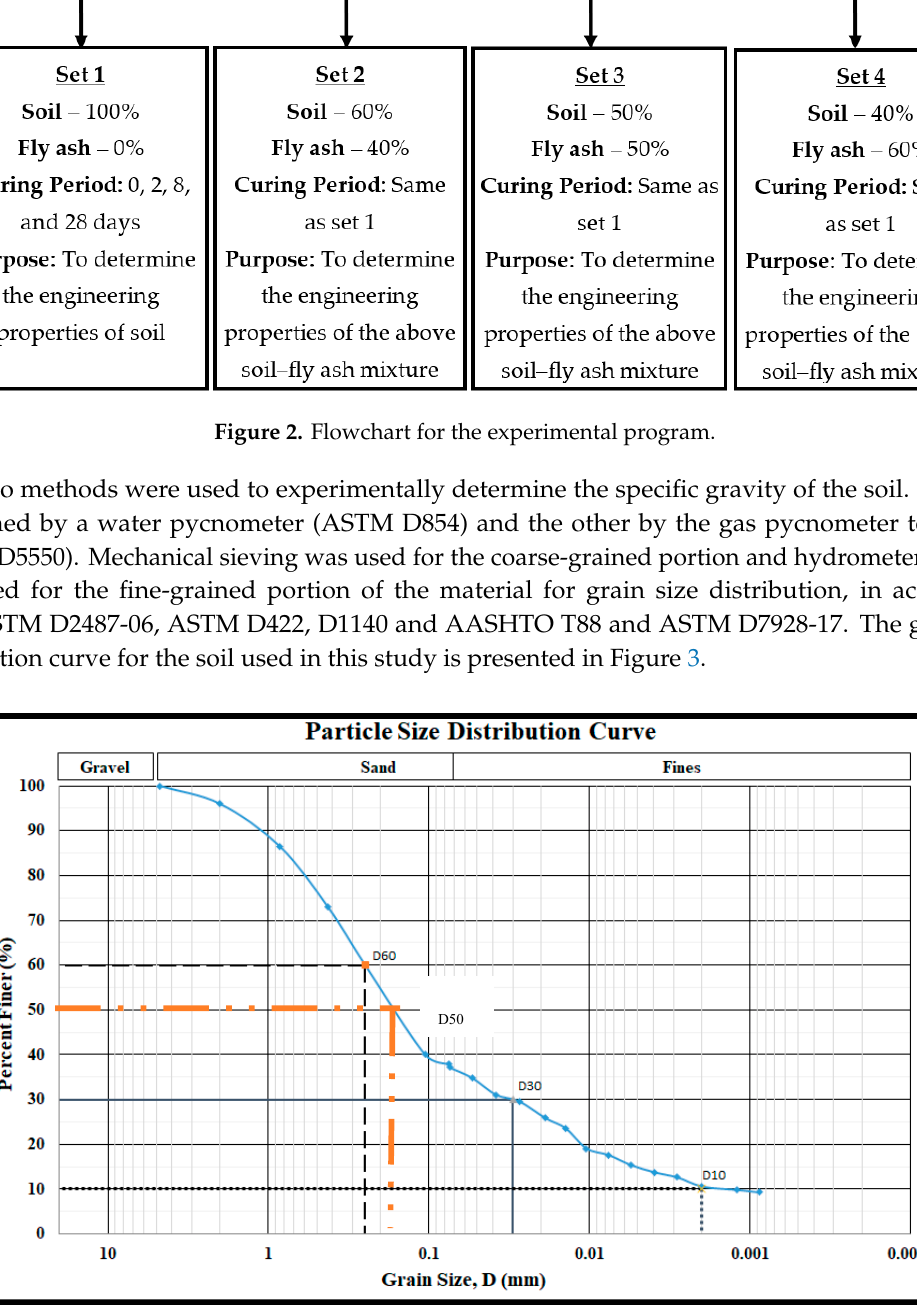
Figure 3. Grain size distribution curve for the soil used in the study .